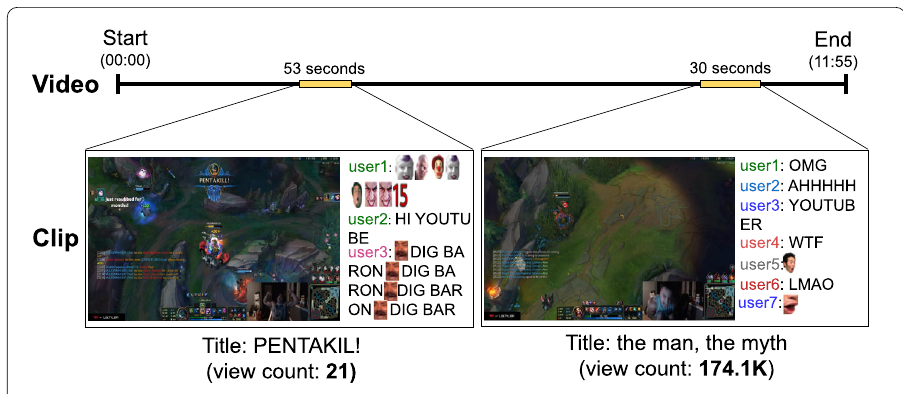
Figure 1 Twitch interface of viewers for watching a video stream (top), creating a clip (bottom left), and browsing recommended clips on the main page (bottom